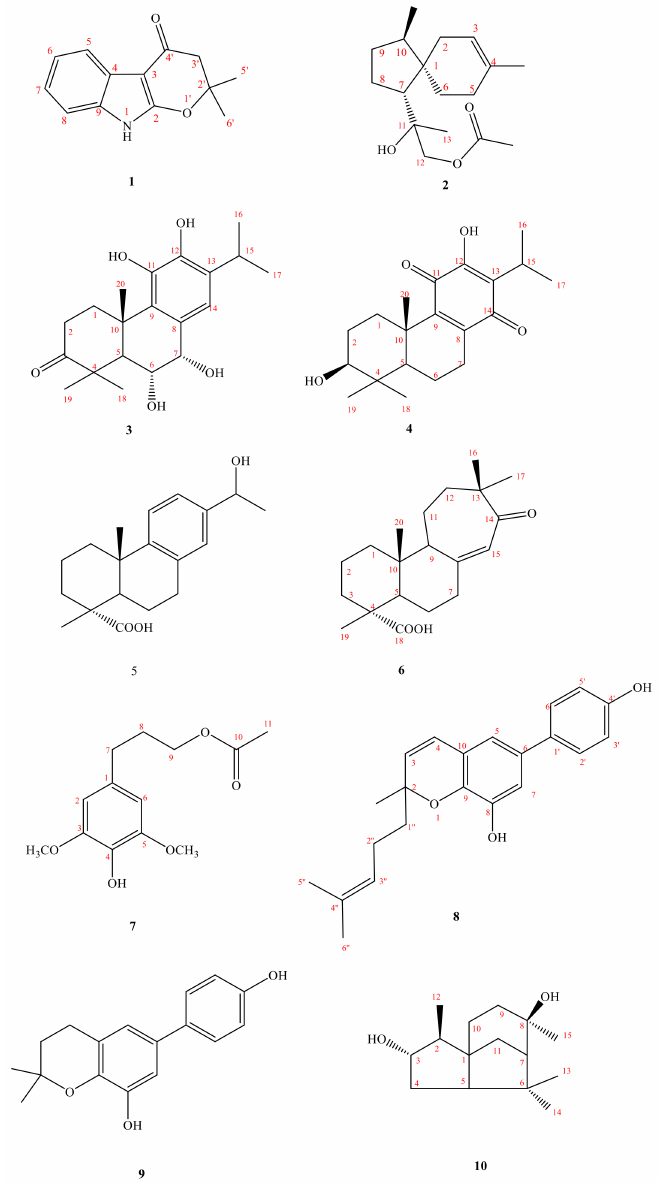
Figure 1. Compounds 1 – 10 , isolated from Amycolatopsis taiwanensis